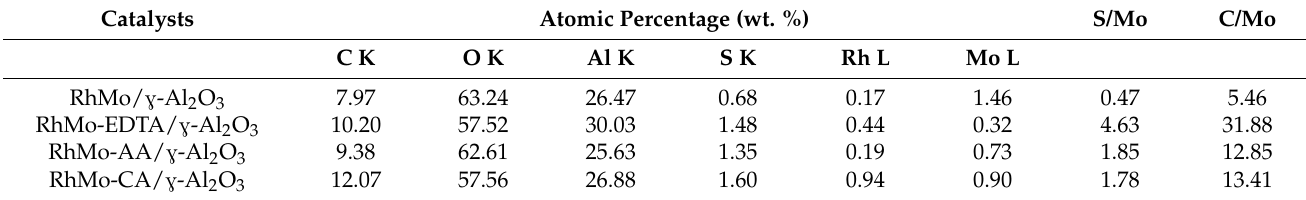
Table 2. Qualitative atomic percentage of Rh, C, O, S and Mo for sulfided HDS catalysts. Catalysts Atomic Percentage (wt.